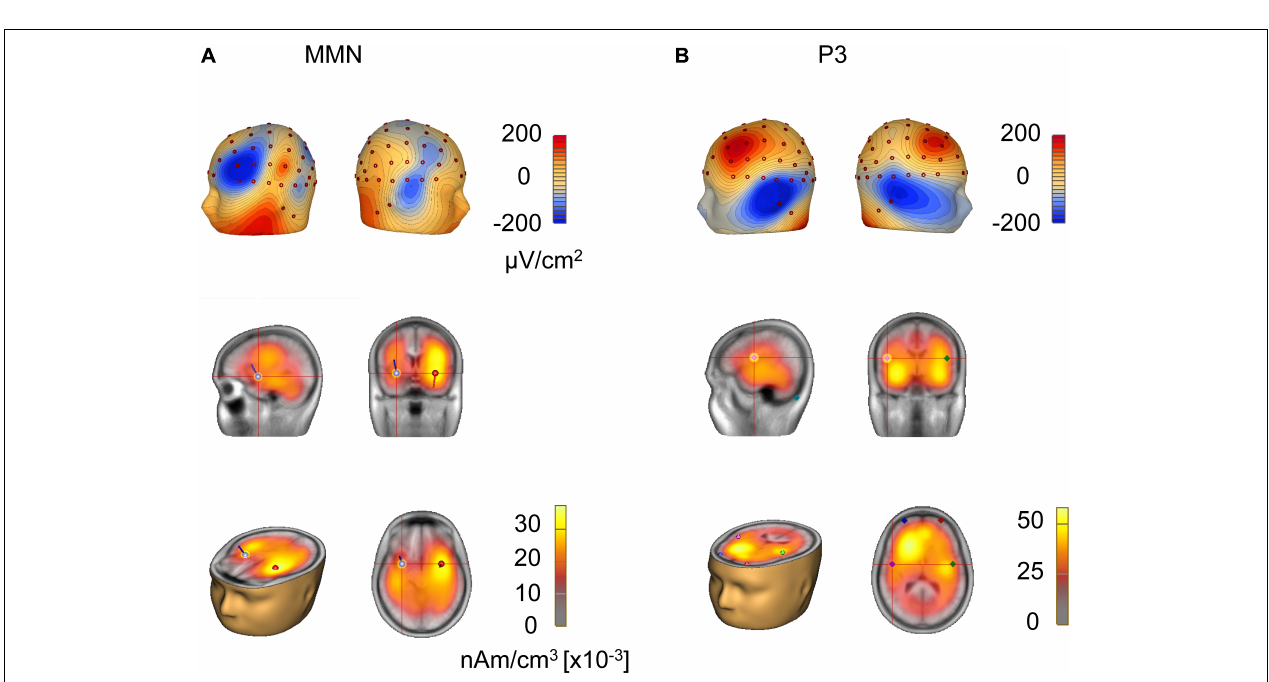
FIGURE 3 | Behavioral results. (A) Plots showing significant difference in percent of correct responses between groups of amateur musicians and non-musicians (*** p < 0.001). (B) The left panel shows significant correlations between the percent of correct responses and MMN amplitude in amateur musicians. The right panel shows significant correlations between the percent of correct responses and P3 amplitude.